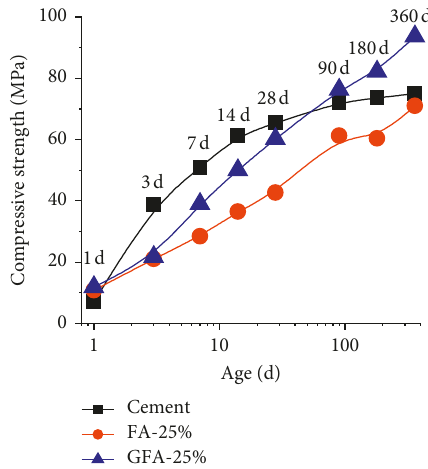
Figure 6: The compressive strength versus ages.